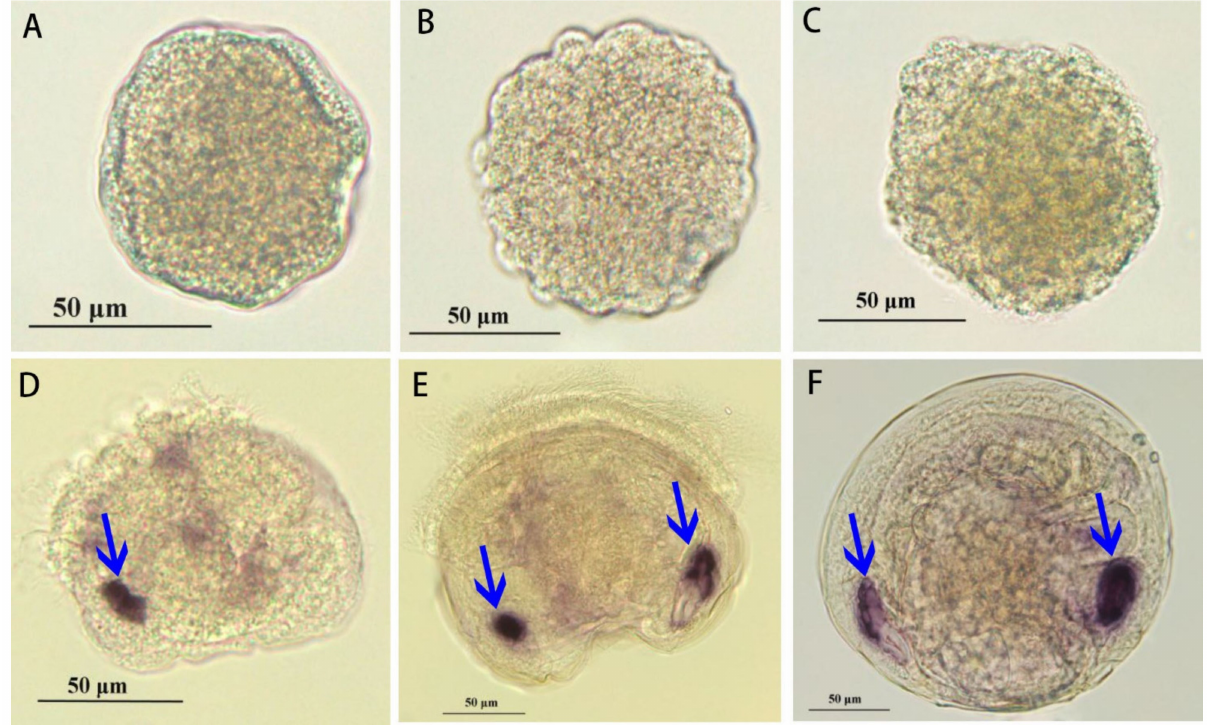
Figure 8. The spatial expression of paramyosin mRNA at different stages determined by whole- mount in situ hybridization. ( A ) multicellular stage; ( B ) blastula; ( C ) trochophore; ( D ) D-veliger stage; ( E ) umbo; and ( F ) spat. Scale bar = 50 µ